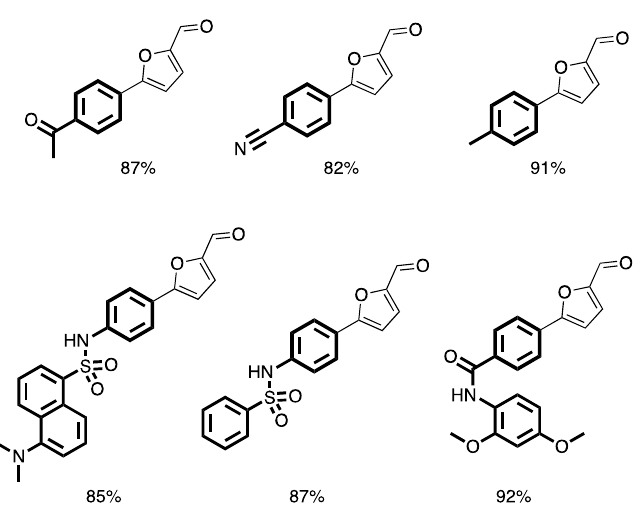
Figure 7. Substrate scope of continuous flow Suzuki–Miyaura cross-coupling sequence using FC1032 catalyst.